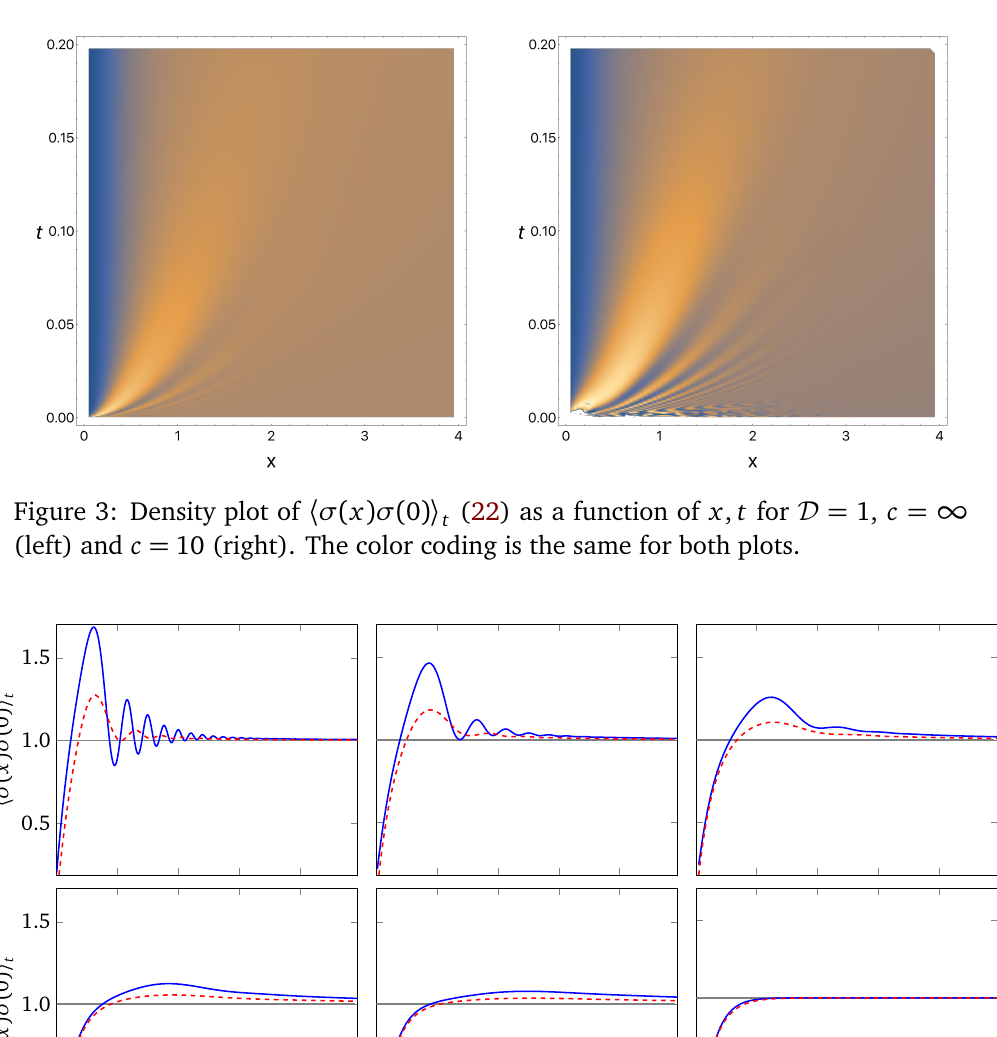
(22) as a function of x , for D = 1, c = ∞ t